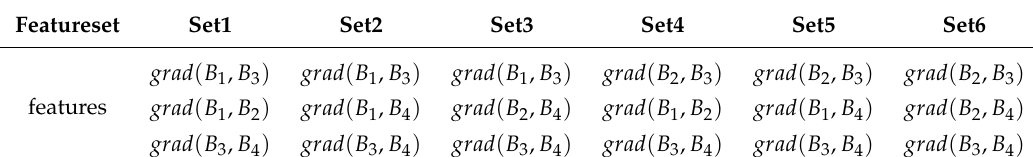
Table 4. The feature sets for contrast.